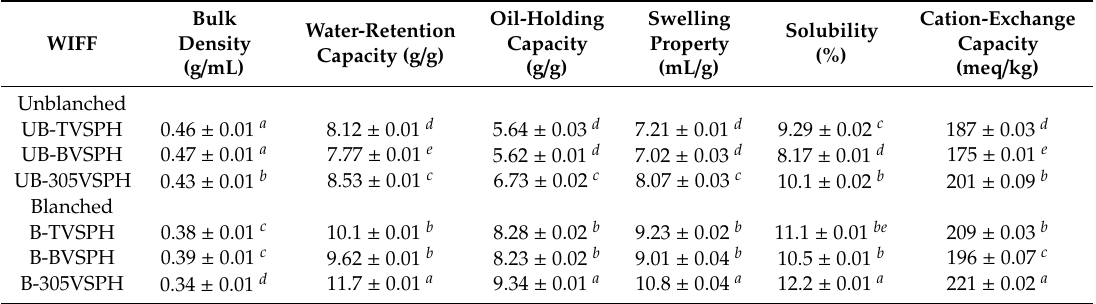
Table 4. Physicochemical properties of WIFF prepared from unblanched and blanched vegetable soybean pod